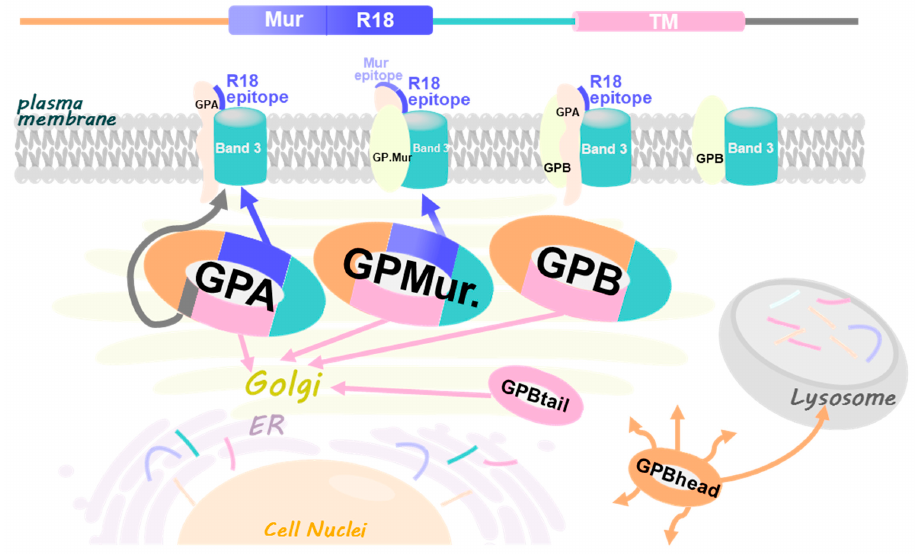
Figure 7. A working model illustrates different trafficking signals encoded in the glycophorin sequence and manifested in glycophorin-AE1 interaction. (TOP) The common sequence of GPA/GPB/GP.Mur and variants are divided in color-coded segments (from left to right, or the N- to the C-terminus): the N-terminal sequence (orange), the Mur epitope (light purple), the R18 epitope (purple); the pre-TMD region that interacts with band 3 and facilitates band 3-mediated anion transport (green); the TMD (pink), and the long C-terminal sequence only in GPA (dark gray). The 5 glycophorin variants studied are each presented in a hoop ring with color segments corresponding to the sequence segments described above. GPA contains all the sequence segments but the Mur epitope. GPB lacks the Mur and the R18 epitopes, as well as the long C-terminus unique to GPA. GP.Mur, evolved from GPB, contains the Mur and the R18 antigens, and also lacks the long C-terminus. GPBtail mainly expresses the TMD. GPBhead mainly expresses the N-terminal glycophorin sequence. The lack of the TMD in GPBhead makes it a diffusive, cytosolic protein destined for the lysosomes. Glycophorin transmembrane is essential for protein retention in the ER and the Golgi apparatus. The glycophorin-R18 epitope (purple) is adjacent to the pre-transmembrane region (green) that includes the Wr b motif (arisen from the AE1-GPA/GP.Mur interaction interface) and functions to assist band 3-mediated anion transport [12,24,26,33,40]. Thus, R18-mediated forward trafficking in GPA and GP.Mur may involve protein–protein interaction with band 3 and co-migration to the cell surface. The long C-terminal sequence of GPA also encodes a forward trafficking signal